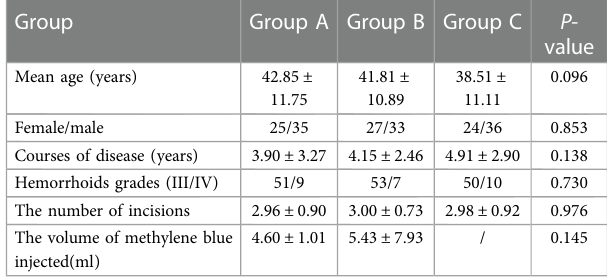
TABLE 1 Comparison of patient demographics and clinical aspects among three